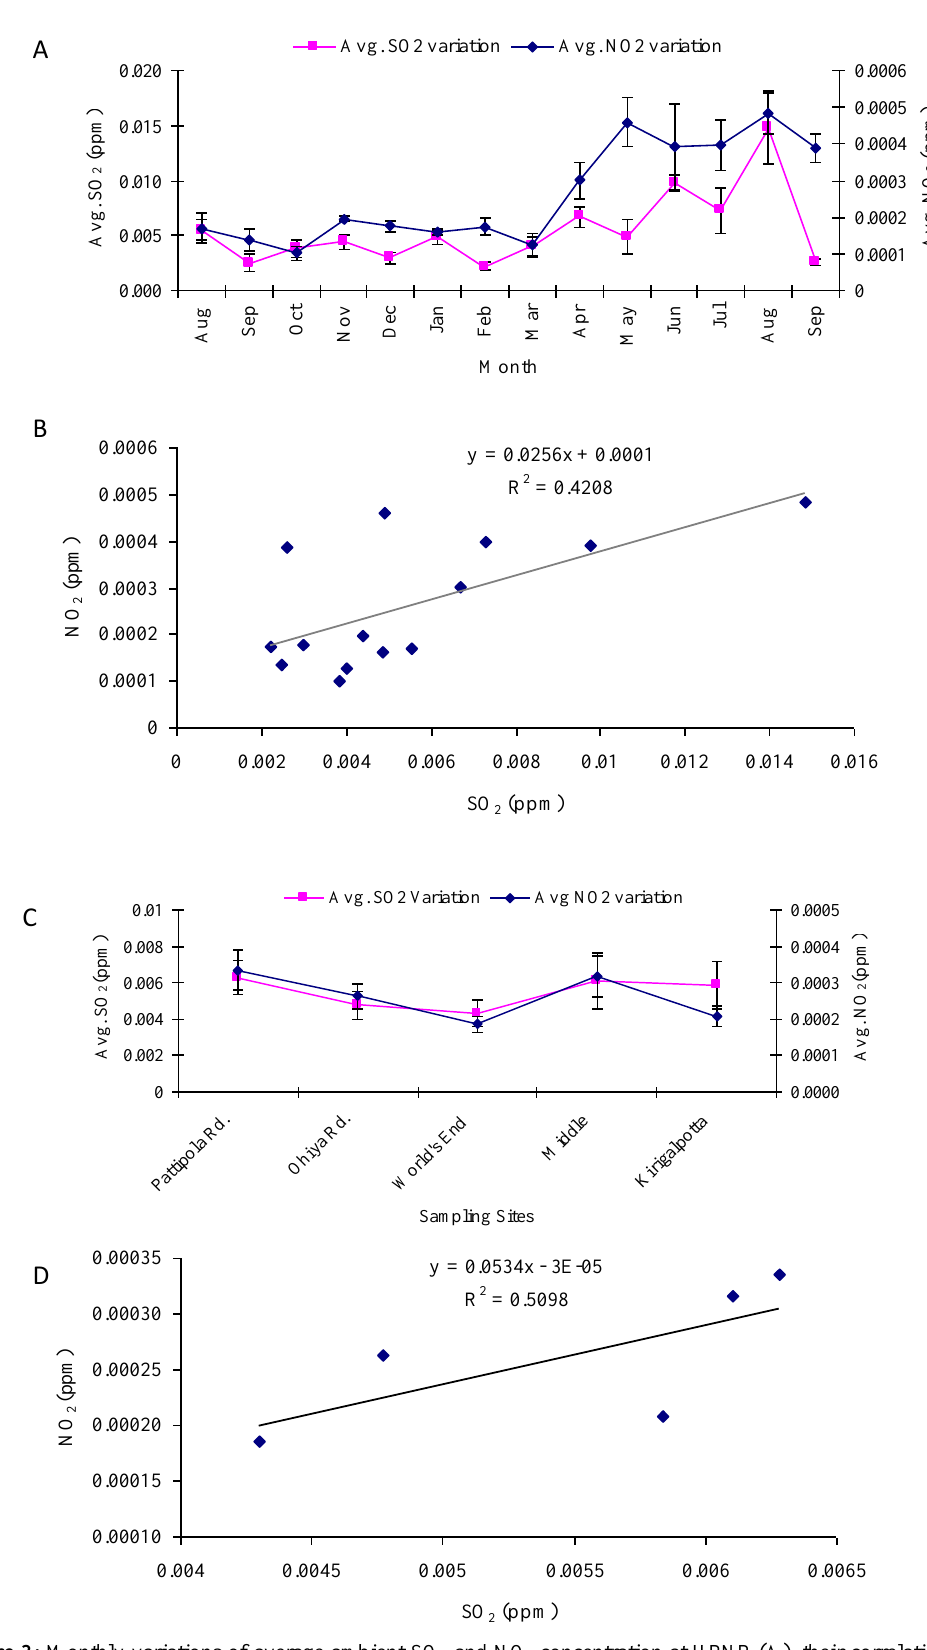
Figure 3: Monthly variations of average ambient SO 2 and NO 2 concentration at HPNP (A), their correlations (B), at each observed point (C) and their correlations